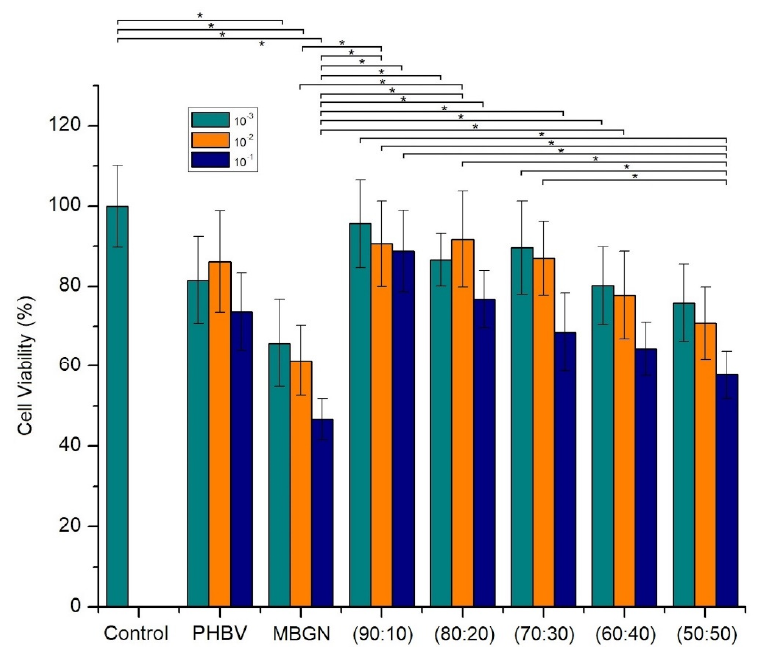
Figure 9. Cell viability of MG-63 cells treated with control (cells without any treatment), pure PHBV microspheres, and microspheres at different MBGN ratios (ten-fold dilutions of 1 mg/mL), after seven days of incubation. (* corresponds to p -value ≤